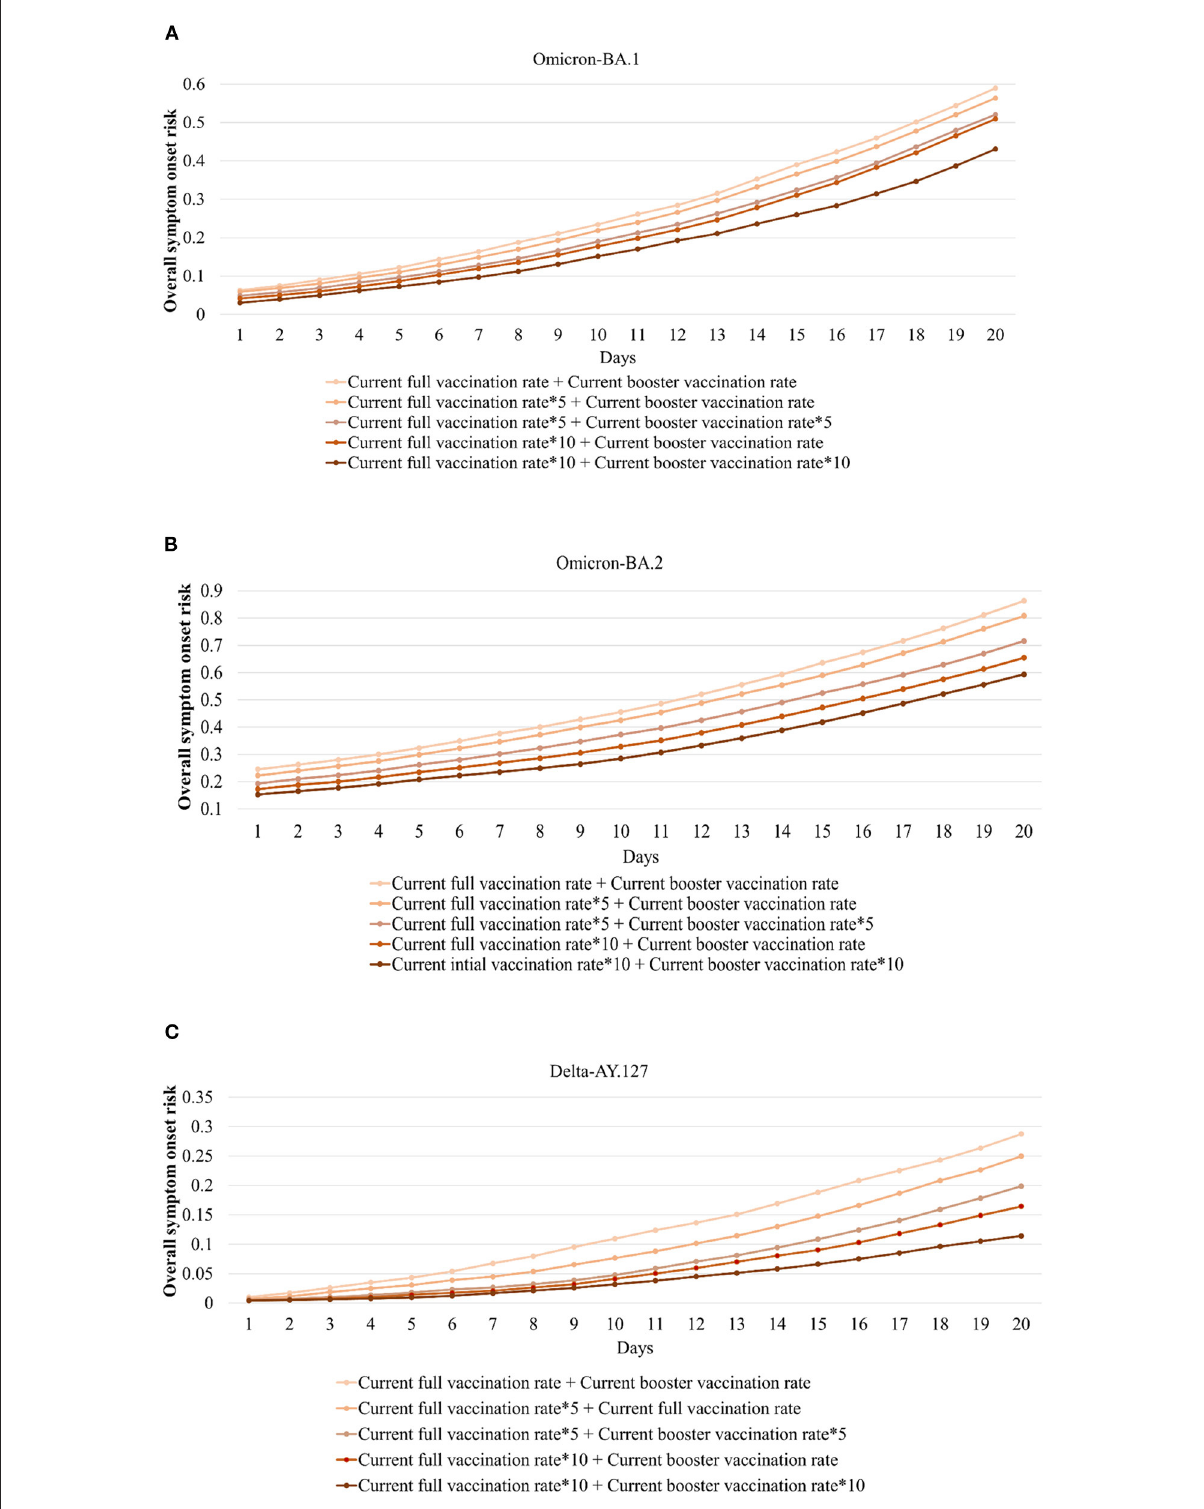
FIGURE7 Daily overall symptom onset risk with the full and booster vaccination rate increased by 5 or 10 times during the 20 days when Omicron BA.1, BA.2, and Delta AY.127 entered the community. (A) indicates daily overall symptom onset risk of Omicron BA.1. (B) indicates daily overall symptom onset risk of Omicron BA.2. (C) indicates daily overall symptom onset risk of Delta